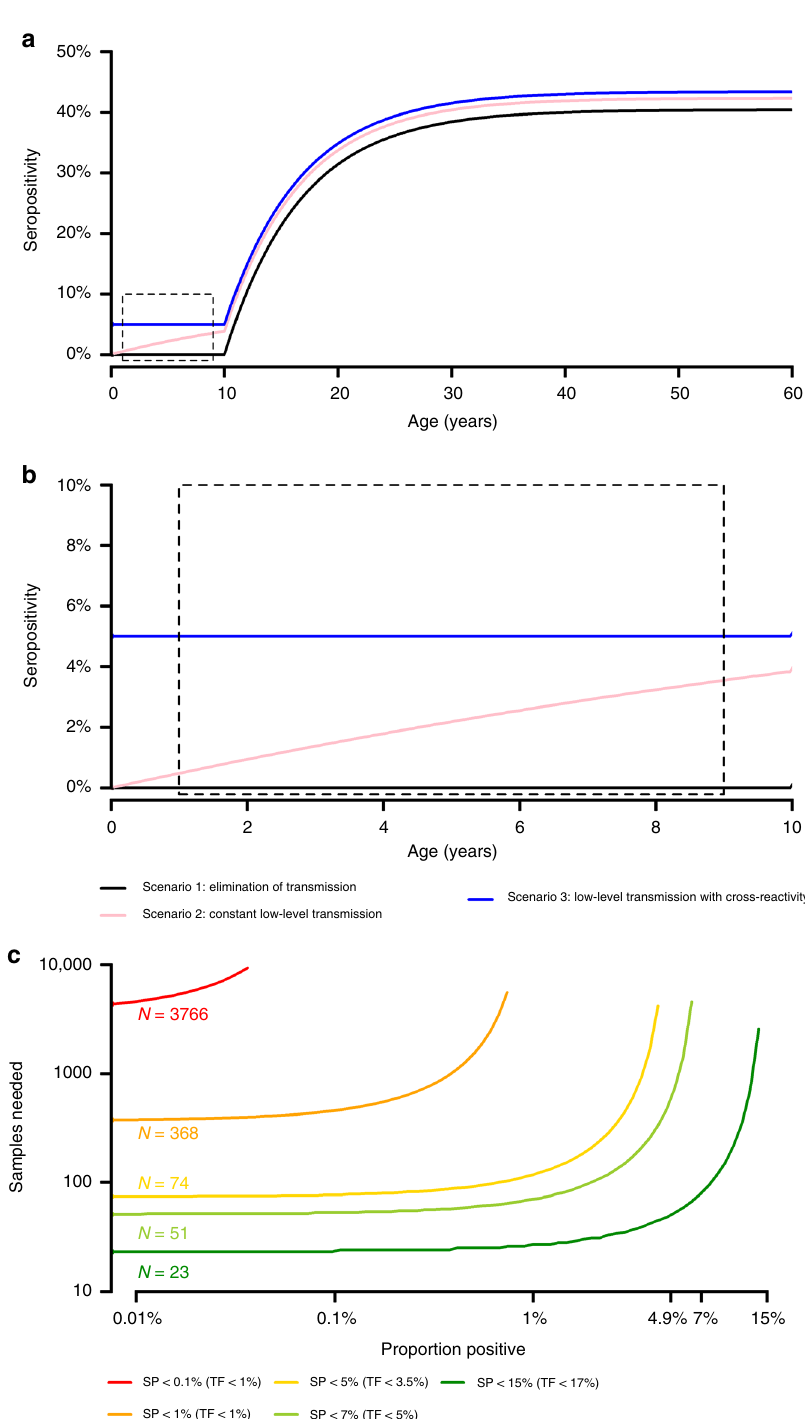
Fig. 4 Modelled age-speci fi c sero-prevalence curves obtained from a community post-elimination. a Scenarios for different average age-speci fi c sero- prevalence curves post-elimination in individuals aged 1 – 60 years old. Each coloured line represents possible data that may be collected following elimination. b A close up of the data presented in ( a ) of the average age sero-prevalence data in individuals only aged 1 – 9 years old. Possible scenarios are that on average there is no age-speci fi c variation in sero-positivity by age (blue line), there is a slight but not substantial increase in sero-positivity with age (pink line), or no sero-positive individuals in the community at all re fl ecting complete elimination (black line). c Estimate of the number of samples required from children aged 1 – 9 years to provide statistical evidence that sero-prevalence is below thresholds of: 0.1%, 1%, 4.9%, 7 and 15%. If the true sero- prevalence = 0% such that all samples test negative, the number of samples required is shown where the curves intersect the y-axis. In the situation where there is some low level of transmission, the number of samples increases substantially. For example, if the true sero-prevalence = 0.5%, then 368 samples are needed to provide evidence of sero-positivity